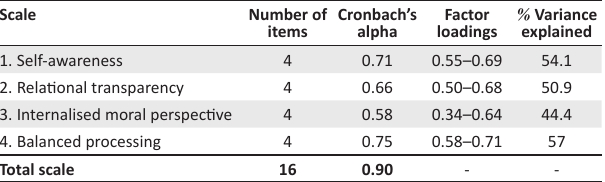
TABLE 1: Reliability and exploratory factor analysis output for the Authentic Leadership Inventory